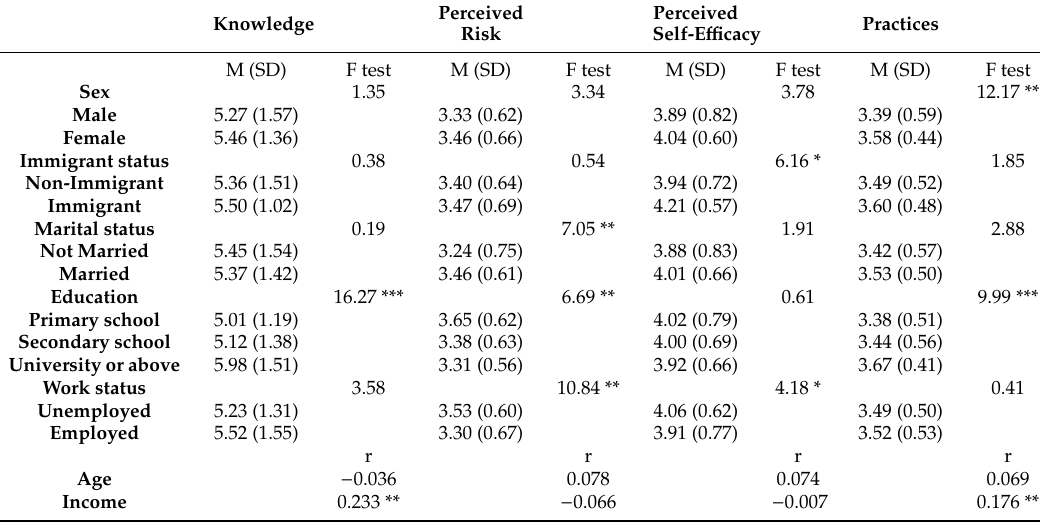
Table 5. Univariate analyses of the associations of socio-demographic characteristics with knowledge, attitudes and practices.